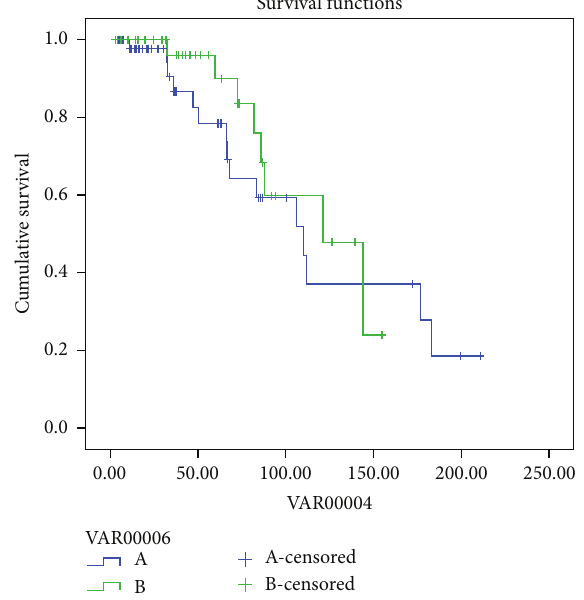
Figure 4: Technique survival PDF (green) and HDPD (anuric) (blue) (log rank 𝑃 = 0.48 ).